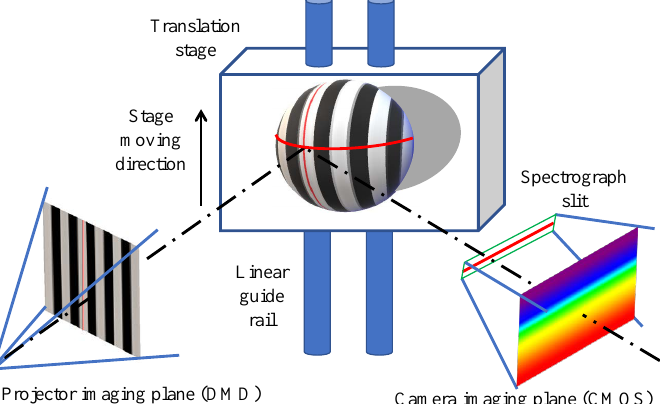
Figure 10. Schematic diagram of the 4D line-scan hyperspectral structured light imager combining fringe patterns projection, stage moving, and slit images acquisition (reprinted with permission from [55] © The Optical